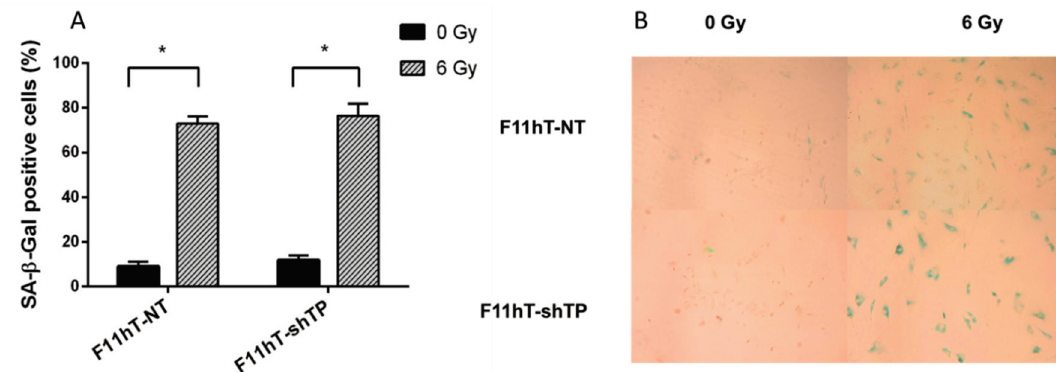
Figure 6. ( A ) Effect of TP53inp1 silencing on radiation induced senescence. Senescence associated- β -galactosidase positive F11hT-NT and F11hT-shTP cells was measured six days after exposure to a single dose of 6 Gy irradiation. Data presented are means ± SEM, n = 9 from three separate experiments. Statistical analysis was performed with one-way ANOVA followed by a Bonferroni post-test. A statistically significant difference p < 0.05 ( * ) is indicated; ( B ) Representative pictures of human fibroblasts (F11hT-NT) and TP53inp1 silenced fibroblasts (F11hT-shTP) were irradiated with 6Gy and stained with SA- β Gal. The sham irradiated control shows exiguous staining, while the 6 Gy irradiated samples are powerfully stained. (Photo: Zeiss Axioskop2plus microscope, 100× magnification; Olympus Camedia camera; 3× optical